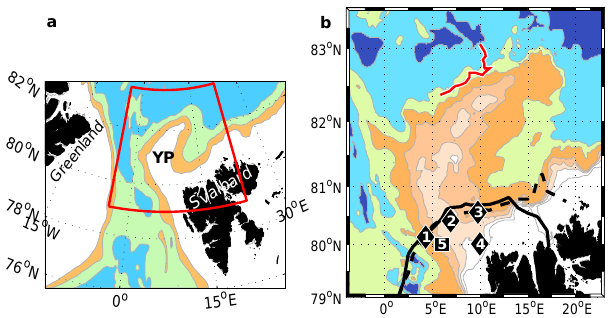
Figure 1. (a) Location map of the study area with the Yermak Plateau (YP) enlarged in (b) . Isobaths are drawn at 1000m inter- vals (Global Relief Model, ETOPO5) in (a) , and at 250m inter- vals to 1000m followed by 1000m intervals (ETOPO1; Amante and Eakins, 2009) in (b) . Stations 1–5 are marked. Station 5 is co-located with the short-term mooring (rectangle). The drift of the CEAREX-O camp is shown by the red line on the north- ern flanks. The ice edge digitized from high-resolution ice charts (http://polarview.org/services/hric.htm) provided by the Norwegian Meteorological Institute are shown for 23 (dashed) and 25 July 2007